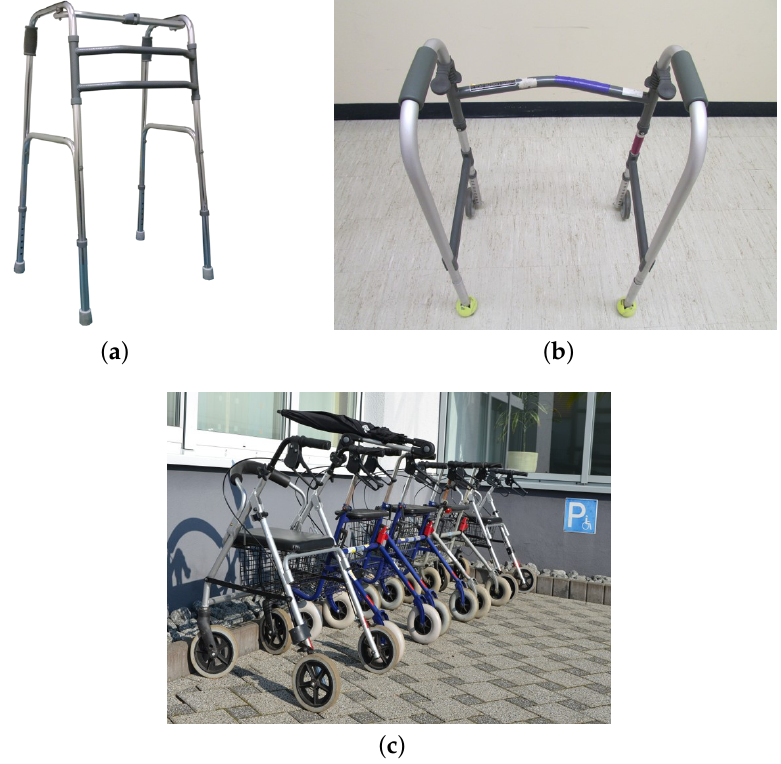
Figure 2. Types of walkers according to their mechanical structure. ( a ) Four-legged; ( b ) front-wheeled [24]; ( c ) rollator